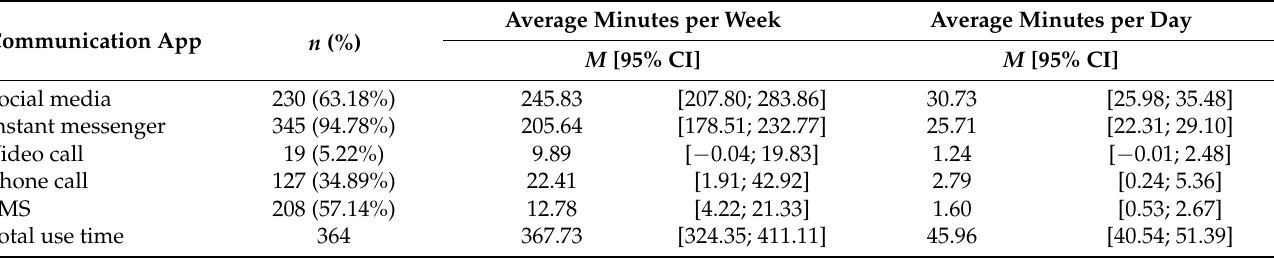
Table 2. Proportions of active app use and average use times grouped by type of communication